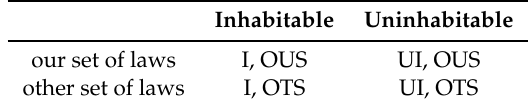
Table 2. Hierarchy of multiverses in view of the hierarchy of physical